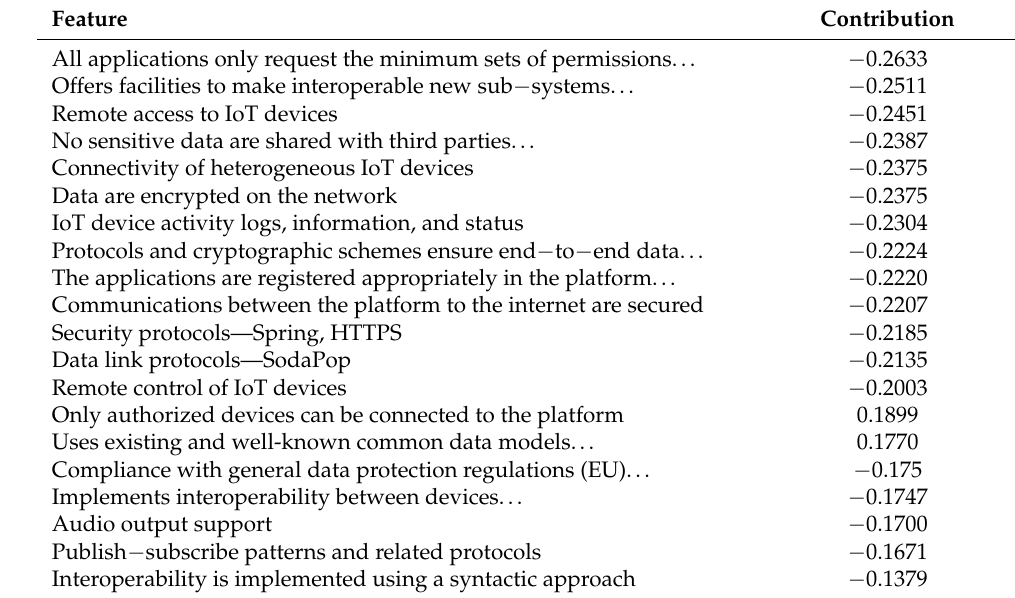
Table 3. Contributions of the top 20 features to the PCA2 component, ordered descending by absolute